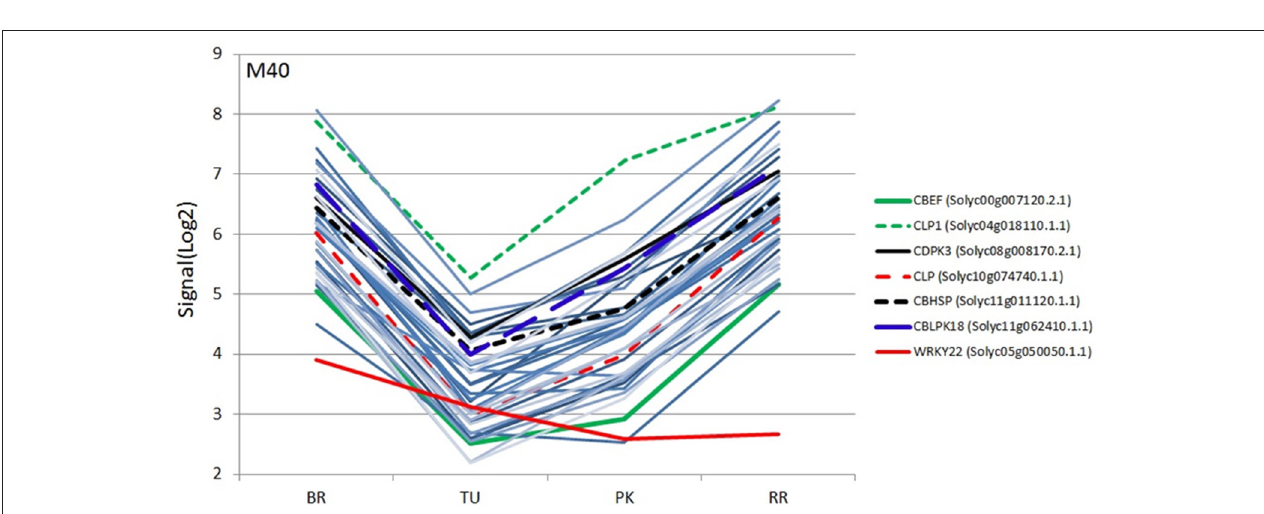
FIGURE 3 | The average fold-change of the two modules, M40 and M6, found to be regulated by the WRKY and the ER24 TFs, respectively.